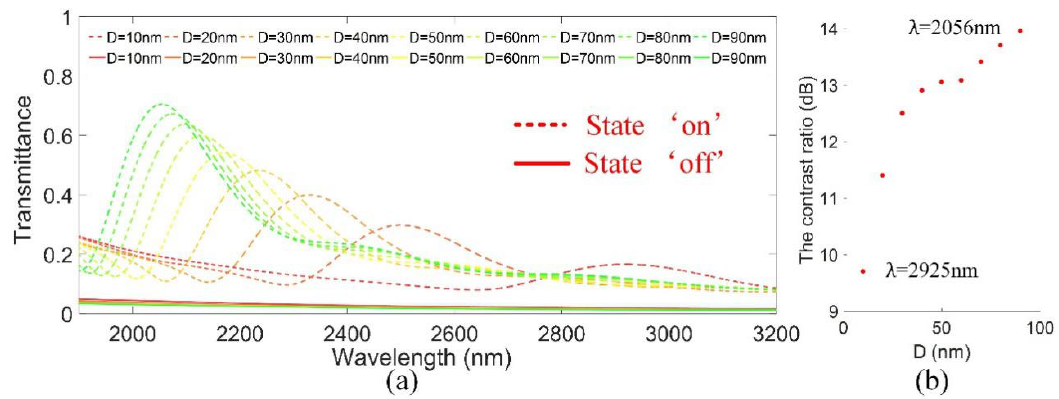
Figure 5. ( a ) Transmittance spectrum of changing the distance D of hoof-shaped structure; ( b ) The contrast ratio and working wavelength of plasmonic optical switch under different distance D .